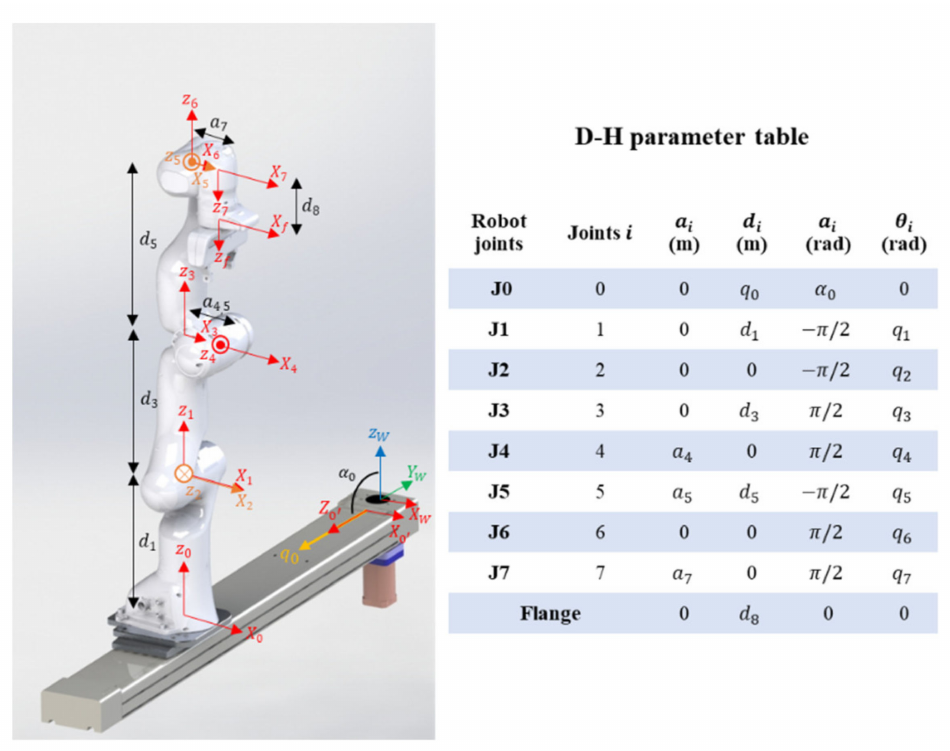
Figure 7. D-H parameters of the 8-DoF robotic assistant